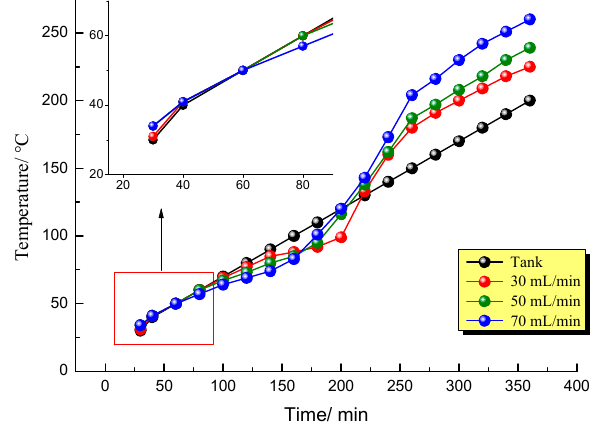
Figure 2. Relationship between the temperature and the time at different air supply rates.